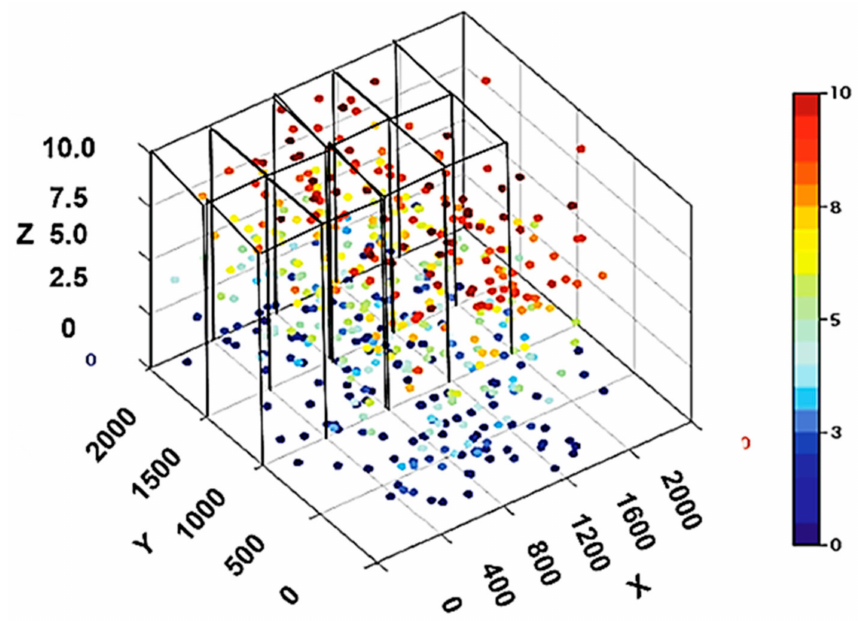
Figure 5. Height Above Ground (HAG) Data in